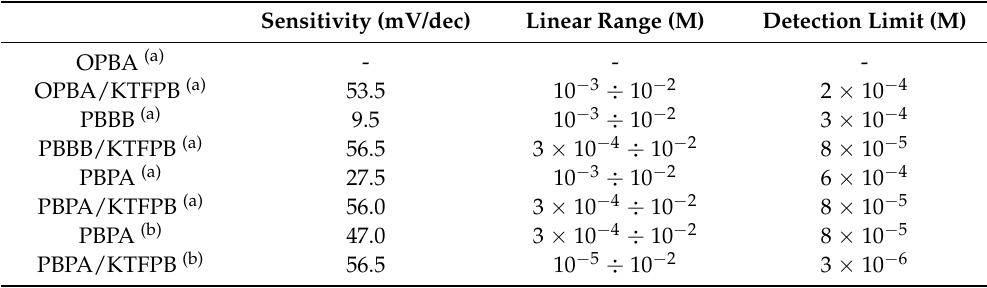
Figure 2. Potentiometric responses of ion-selective electrodes formulated with organoboron receptors (PVC/DOS, 10 mol% KTFPB) towards dopamine. Table 1. Values of sensitivity, limit of detection and linear range of the potentiometric responses of ion-selective electrodes formulated with the studied organoboron receptors (with and without KTFPB in membranes) towards: ( a ) dopamine and ( b ) 2-phenylethylamine.